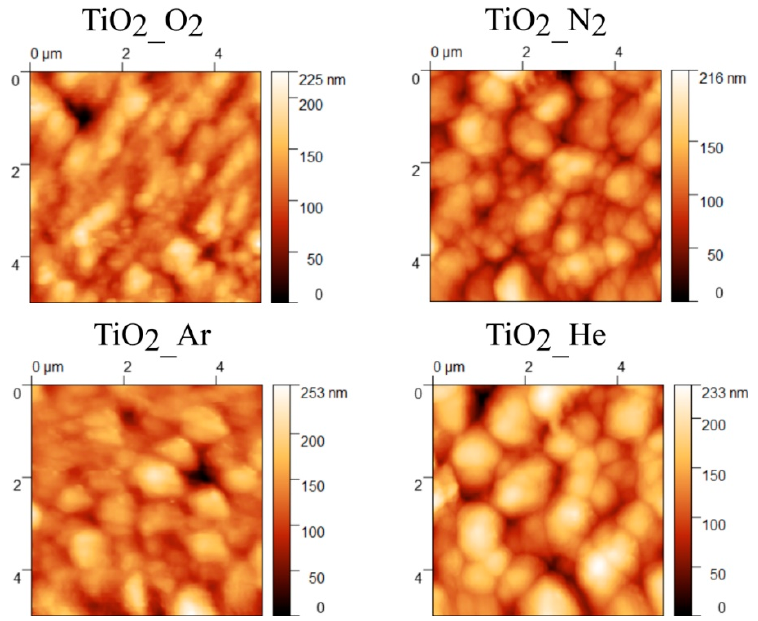
Figure 3. Typical AFM micrographs (5 × 5 µm 2 investigation area) of the coatings deposited by PLD under different gas environments (O 2, N 2 , Ar, and He).